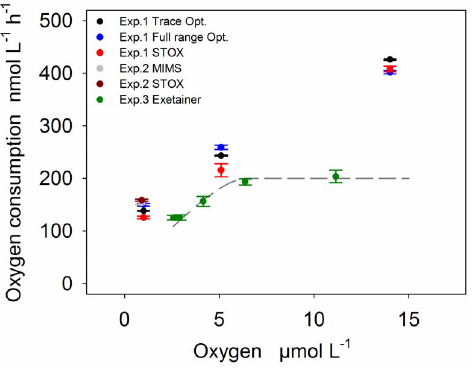
Figure 7. O 2 consumption rates versus O 2 concentrations. The O 2 consumption rates of Experiment 1, 2 and 3 are summarized and plotted over the initial O 2 concentrations of the respective incubation. Experiment 3: The dashed line represents diffusion limited rates estimated from equation 4 assuming aggregate diameters (r 0 ) of 0.14 mm. Please note: rates in Experiment 1 also increase with incubation time and could as well reflect bacterial growth over time.